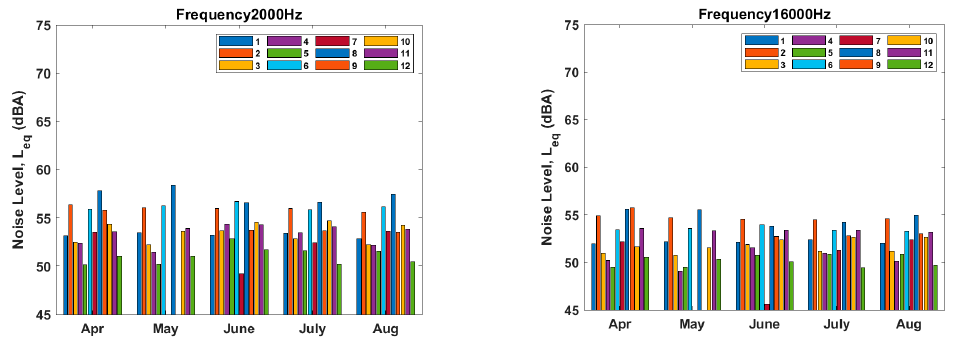
Figure 5. Di ff erent sensor averages at 2000 Hz and 16,000 Hz for di ff erent months. Figure 5. Different sensor averages at 2000 Hz and 16,000 Hz for different months.